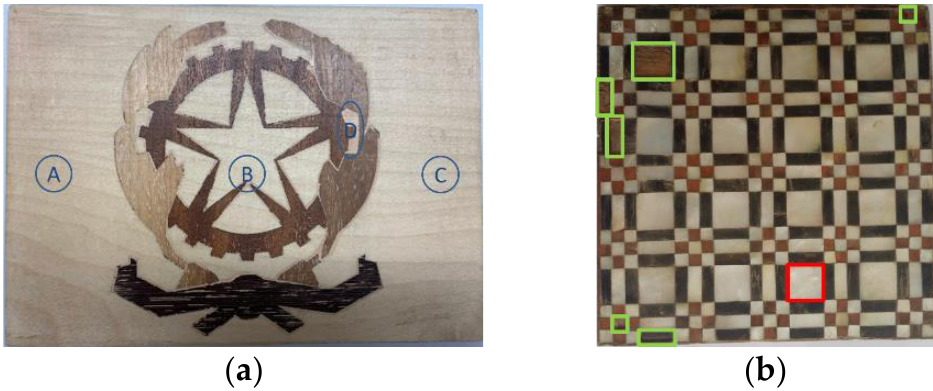
Figure 5. Marquetry samples: ( a ) a panel representing arms’ coats and ( b ) an ancient sample. The Figures were redrawn considering Refs. [43,58].